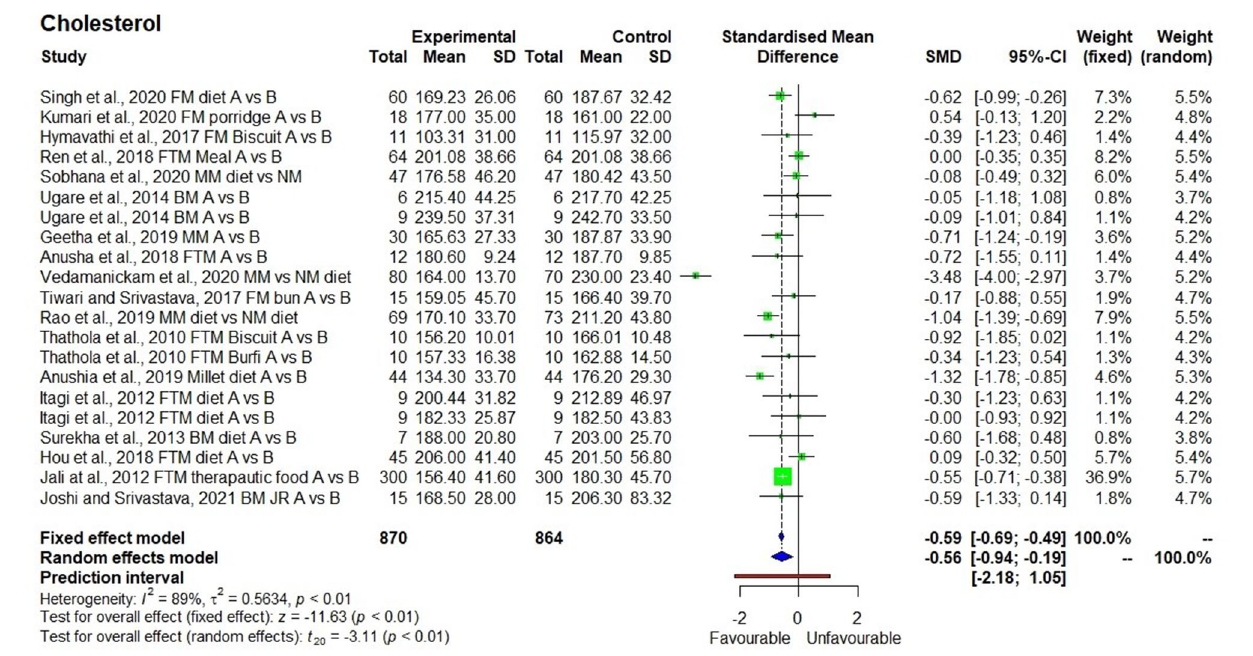
FIGURE 2 | Effect of consuming millets on total cholesterol level (pre- vs. post-treatment or intervention vs. control